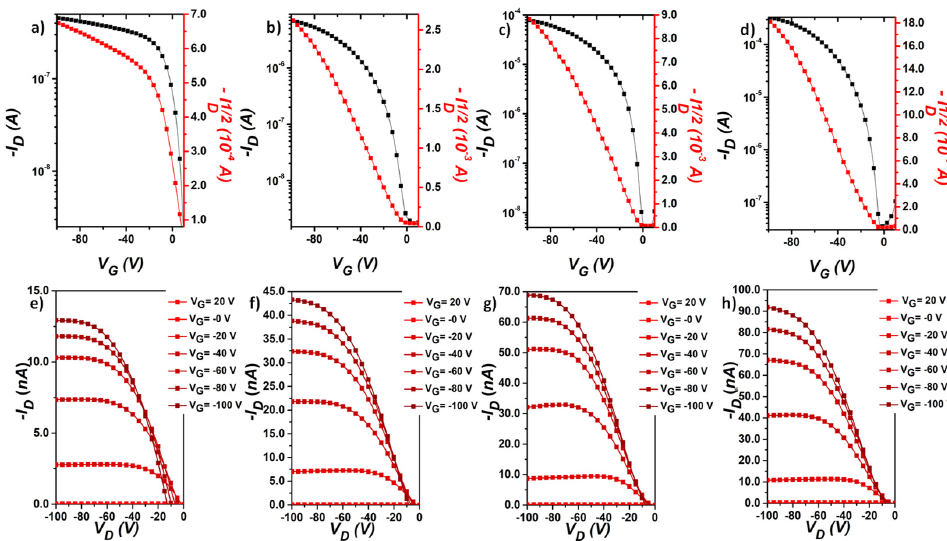
Figure 3. Bottom-gate bottom-contact (BGBC) OFET characteristics for P(FDPP-TP) polymer. ( a ) Transfer curve; ( e ) output curve; ( b ) non-annealed (room temperature) transfer curve; ( f ) non-an- nealed (room temperature) output curve; ( c ) transfer curve at 100 °C; ( g ) output curve at 150 °C; ( d ) transfer curve at 200 °C; ( h ) output curve at 200 °C.